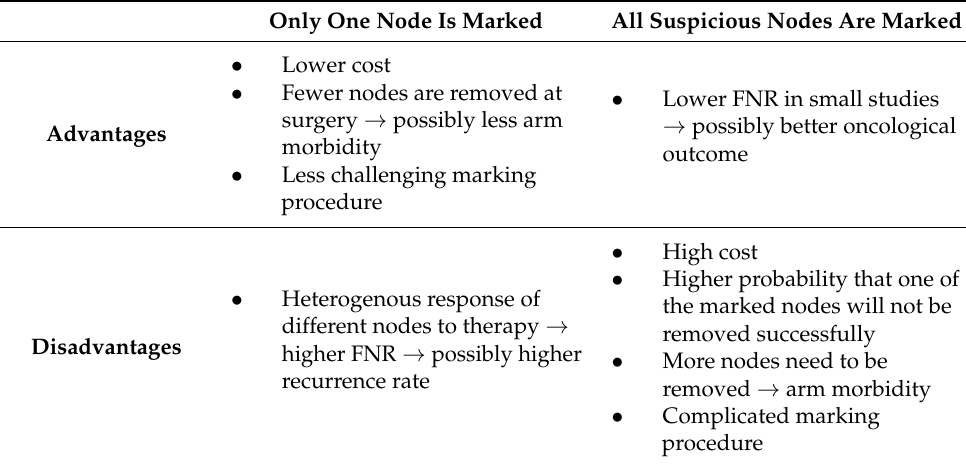
Table 6. Potential strategies regarding the number of marked nodes. Only One Node Is Marked All Suspicious Nodes Are